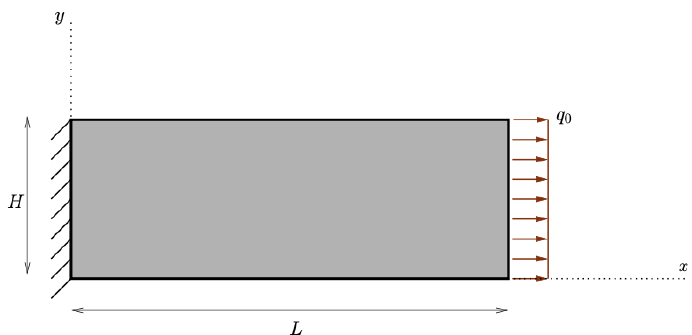
Figure 9. Schematic for the tensile test under a uniform load q 0 .